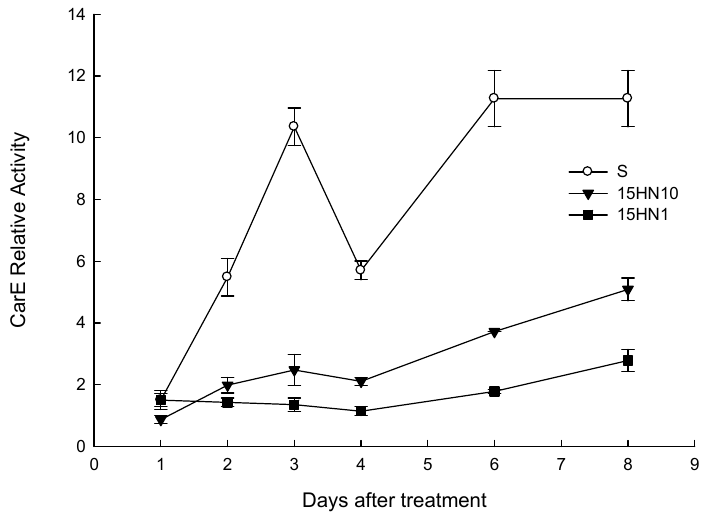
Figure 4. Relative activities of carboxylesterase in resistant (15HN10, 15HN1) and susceptible (S) Digitaria sanguinalis populations.